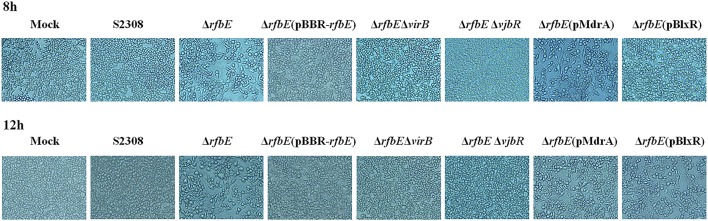
Phase-contrast microscopy. RAW264.7 cells cultured in a 24-well plate were infected with S2308, ΔrfbE, ΔrfbE(pBBR-rfbE), ΔrfbEΔvirB, ΔrfbEΔvjbR, ΔrfbE(pMdrA), and ΔrfbE(pBlxR) mutants at a MOI of 100. The cells were observed at a magnification of ×200 at 8 and 12 hpi. Uninfected RAW264.7 cells were used as negative controls (Mock).